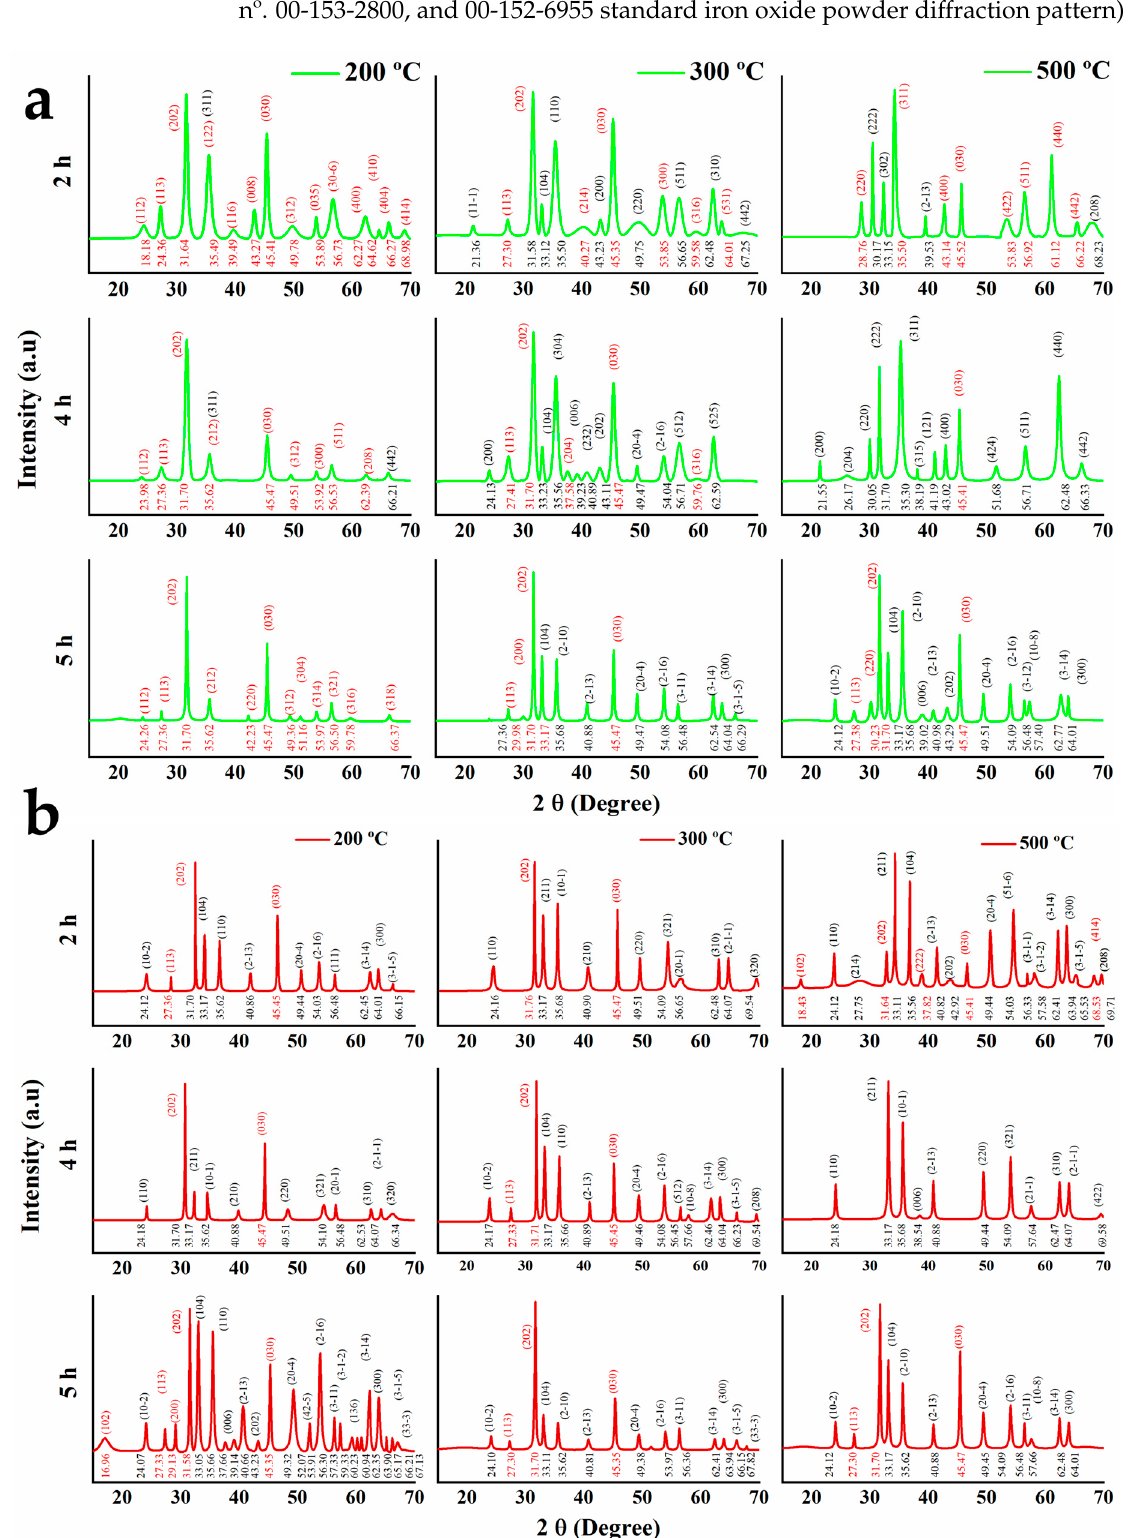
Figure 1. XRD patterns of the nanoparticles (JCPDS standard) calcined at different temperatures (200, 300, and 500 ◦ C) and times (2, 4, and 5 h): ( a ) GS-NPs profile using aqueous extracts of PDL and ( b ) CS-NPs profile using